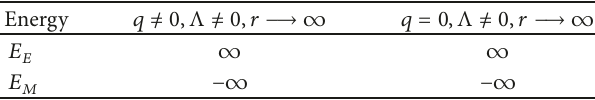
Table 3: Limiting behavior of the energy of the massless black hole solution in the Einstein and Møller